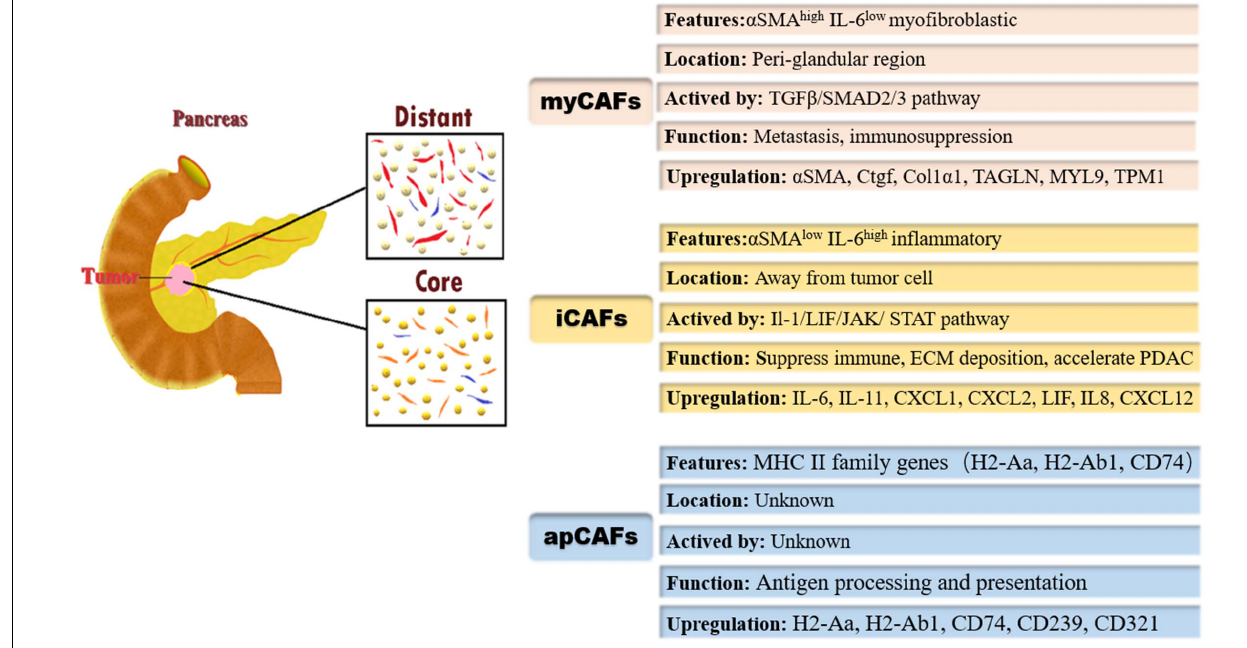
α -SMA (Albrengues et al., 2014). Biffi et al. (2019) identified